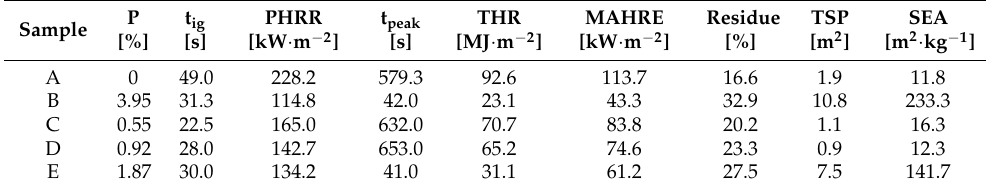
Figure 16. Heat Release Rate (HRR) versus time curves for all the samples. Table 4. Cone calorimetry data obtained for all samples.